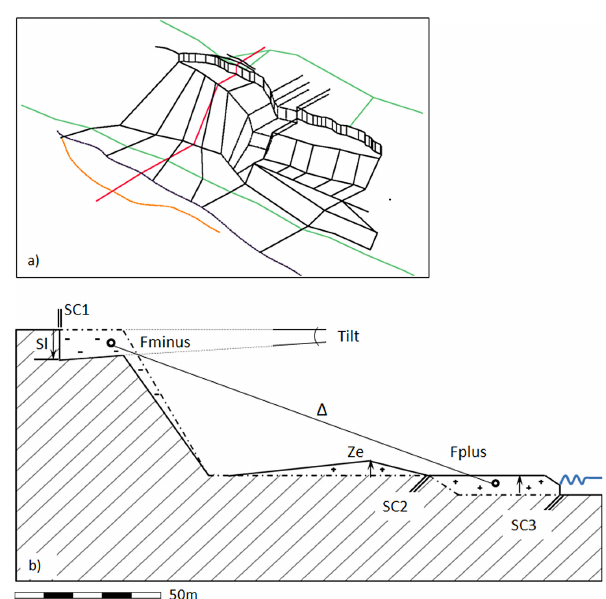
Fig. 4. Geometric models; (a) generalized 3-D model, main geode- tic profiles (green), front of the bulge in Danube river (yellow); (b) representative longitudinal profile, the location is shown as a red line in Fig. 4a; SC1, SC2; SC3 are scarps and outcrops of slid- ing planes, Fminus and Fplus are ablation and accumulation areas, Sl is a Lagrangian movement at the main scarp, Tilt is the angle of rotation of the uppermost sliding block, Ze is a Eulerian uplift at the river bank, the water level of Danube river is the blue wiggly